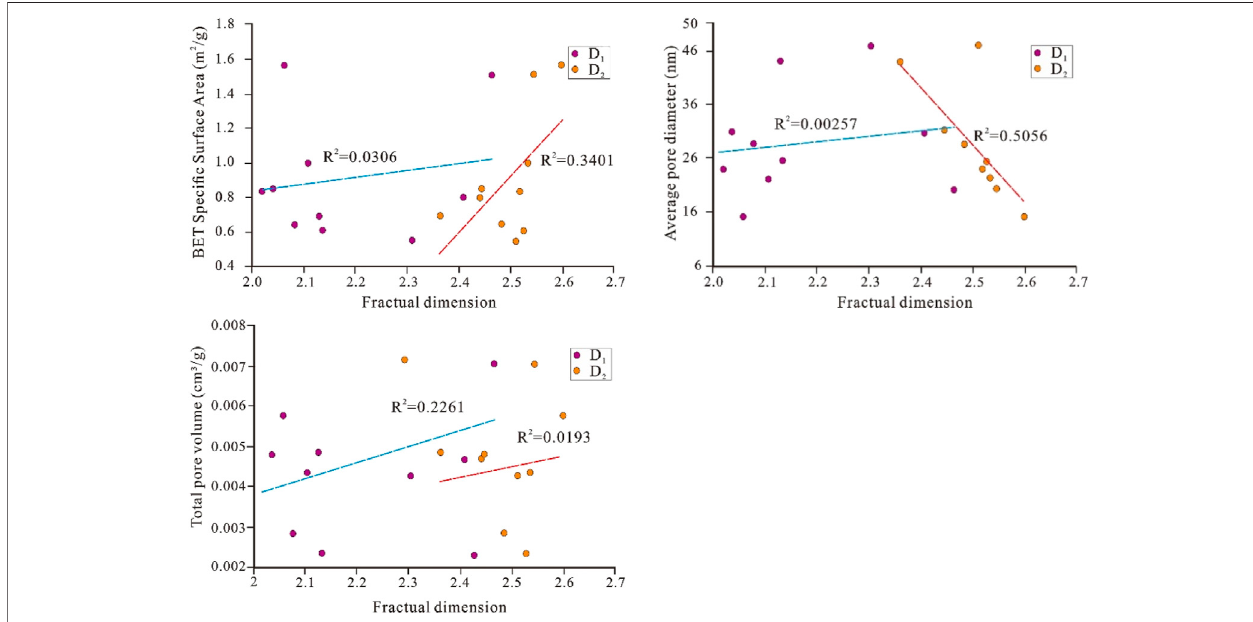
FIGURE 11 | The scatter diagrams and correlations of fractal dimensions vs pore structure parameters.